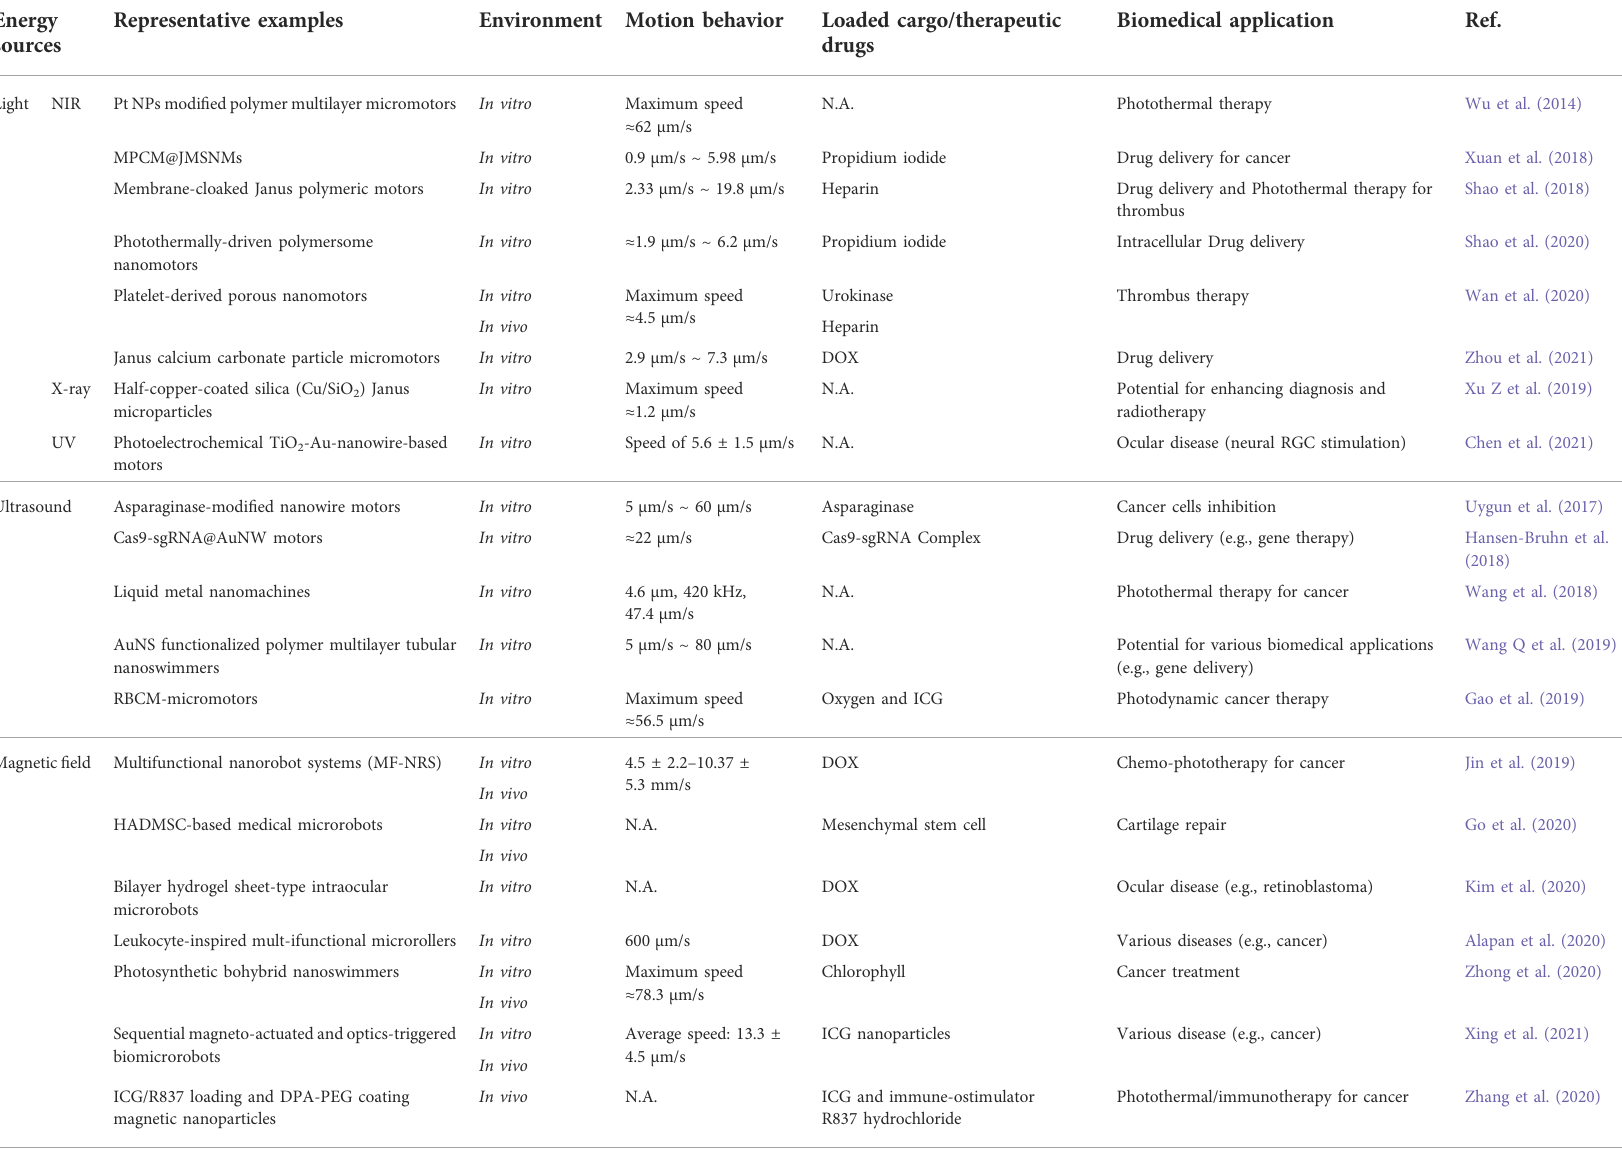
TABLE 2 External- fi eld-powered MNRs for motile-targeting drug